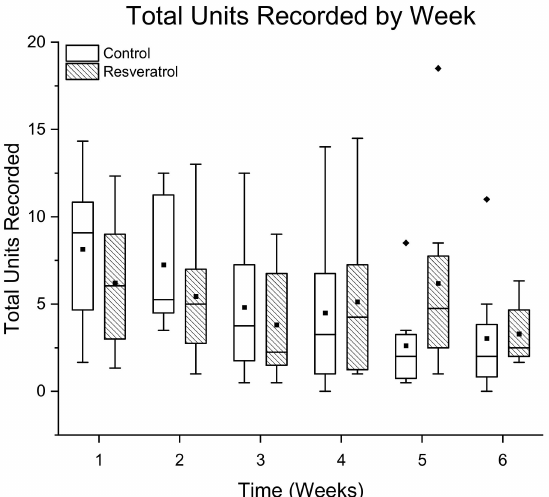
Figure 2. Recording performance of the number of total single units detected in animals administered resveratrol via intraventricular delivery (dashed box) compared to control animals (white box) by week. The total units recorded in the resveratrol group were not significantly different than the controls when compared week by week. The interaction term was significant, indicating a higher slope for the resveratrol group compared to the control group. N = 8 animals per group with 10 channels per animal. The whiskers represent the range within 1.5 IQR, the lines inside the boxes represent the median line, the solid squares in the middle represent the mean and the diamonds represent